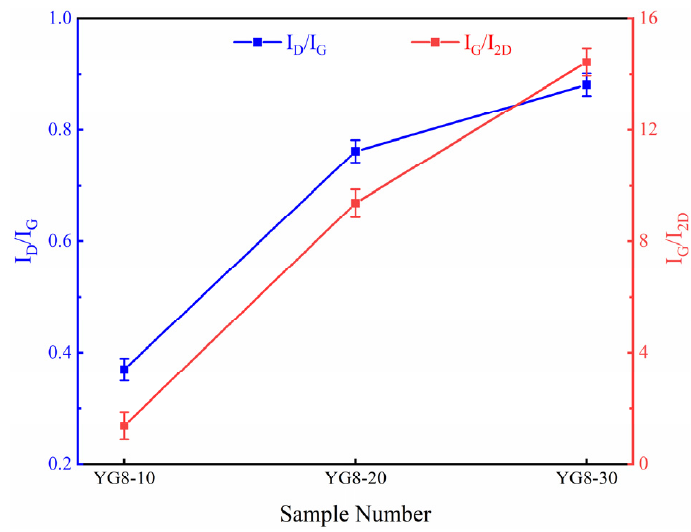
Figure 8. The I D / I G , I G / I 2 D value at different methane flows.